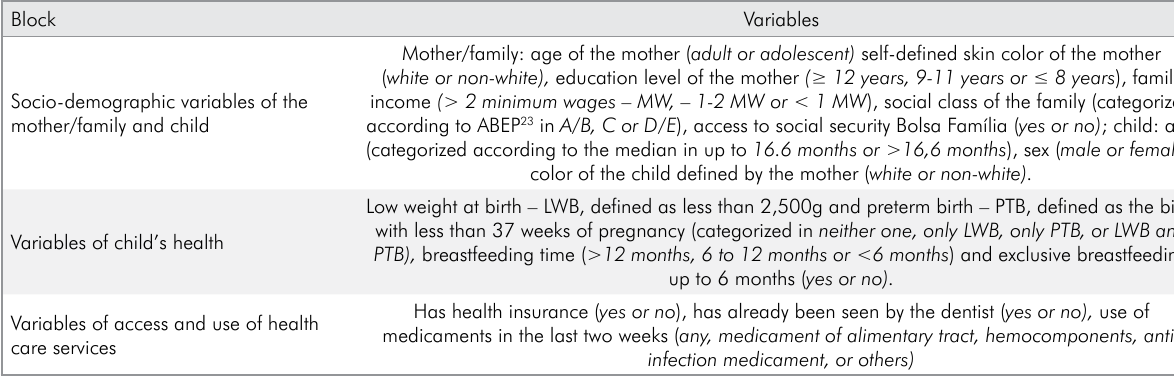
Table 1. Description of the variables of the hierarchized model. Block Variables